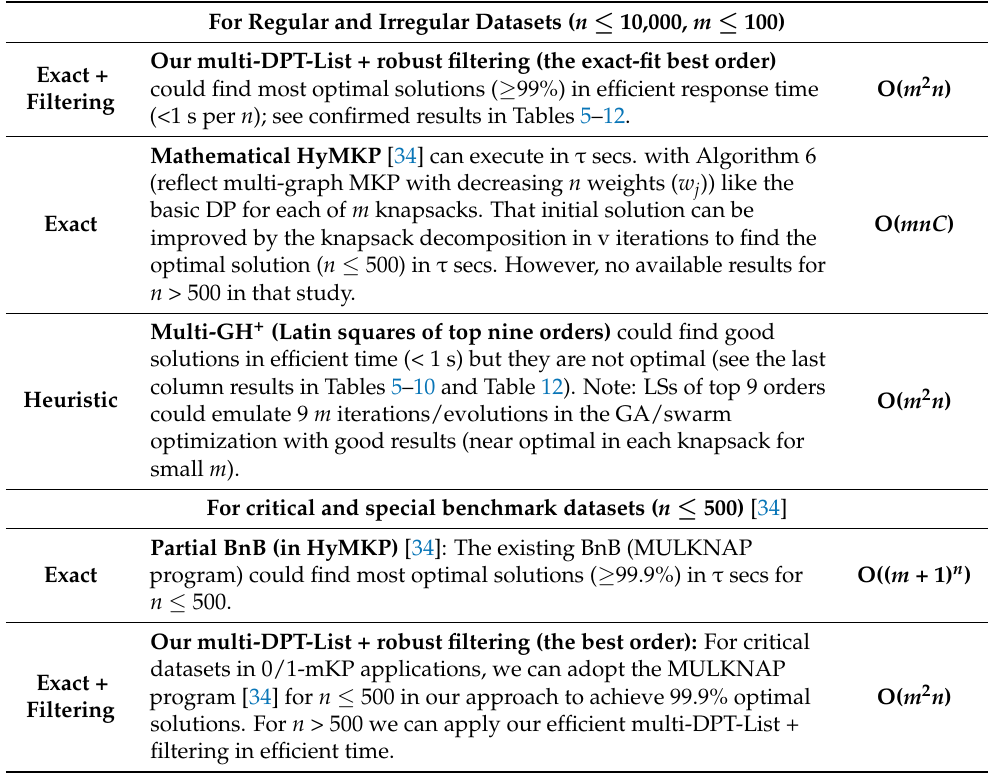
Table 14. Comparison of our multi-DPT-List + robust filtering and the mathematical HyMKP. For Regular and Irregular Datasets ( n ≤ 10,000, m ≤